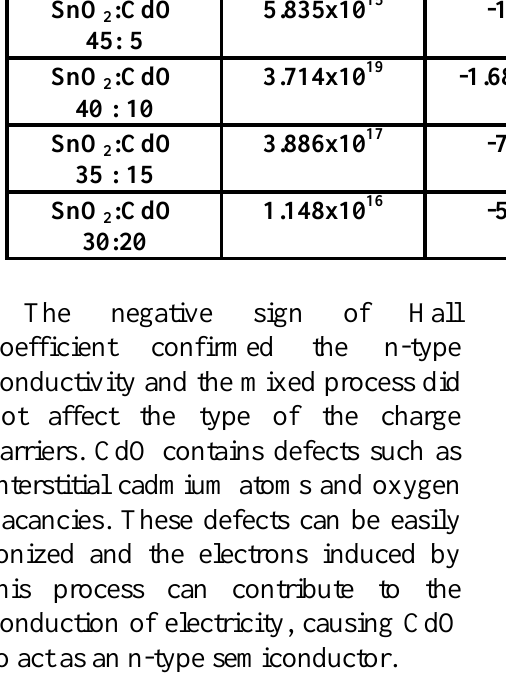
Table 4: Hall measurements of SnO addition